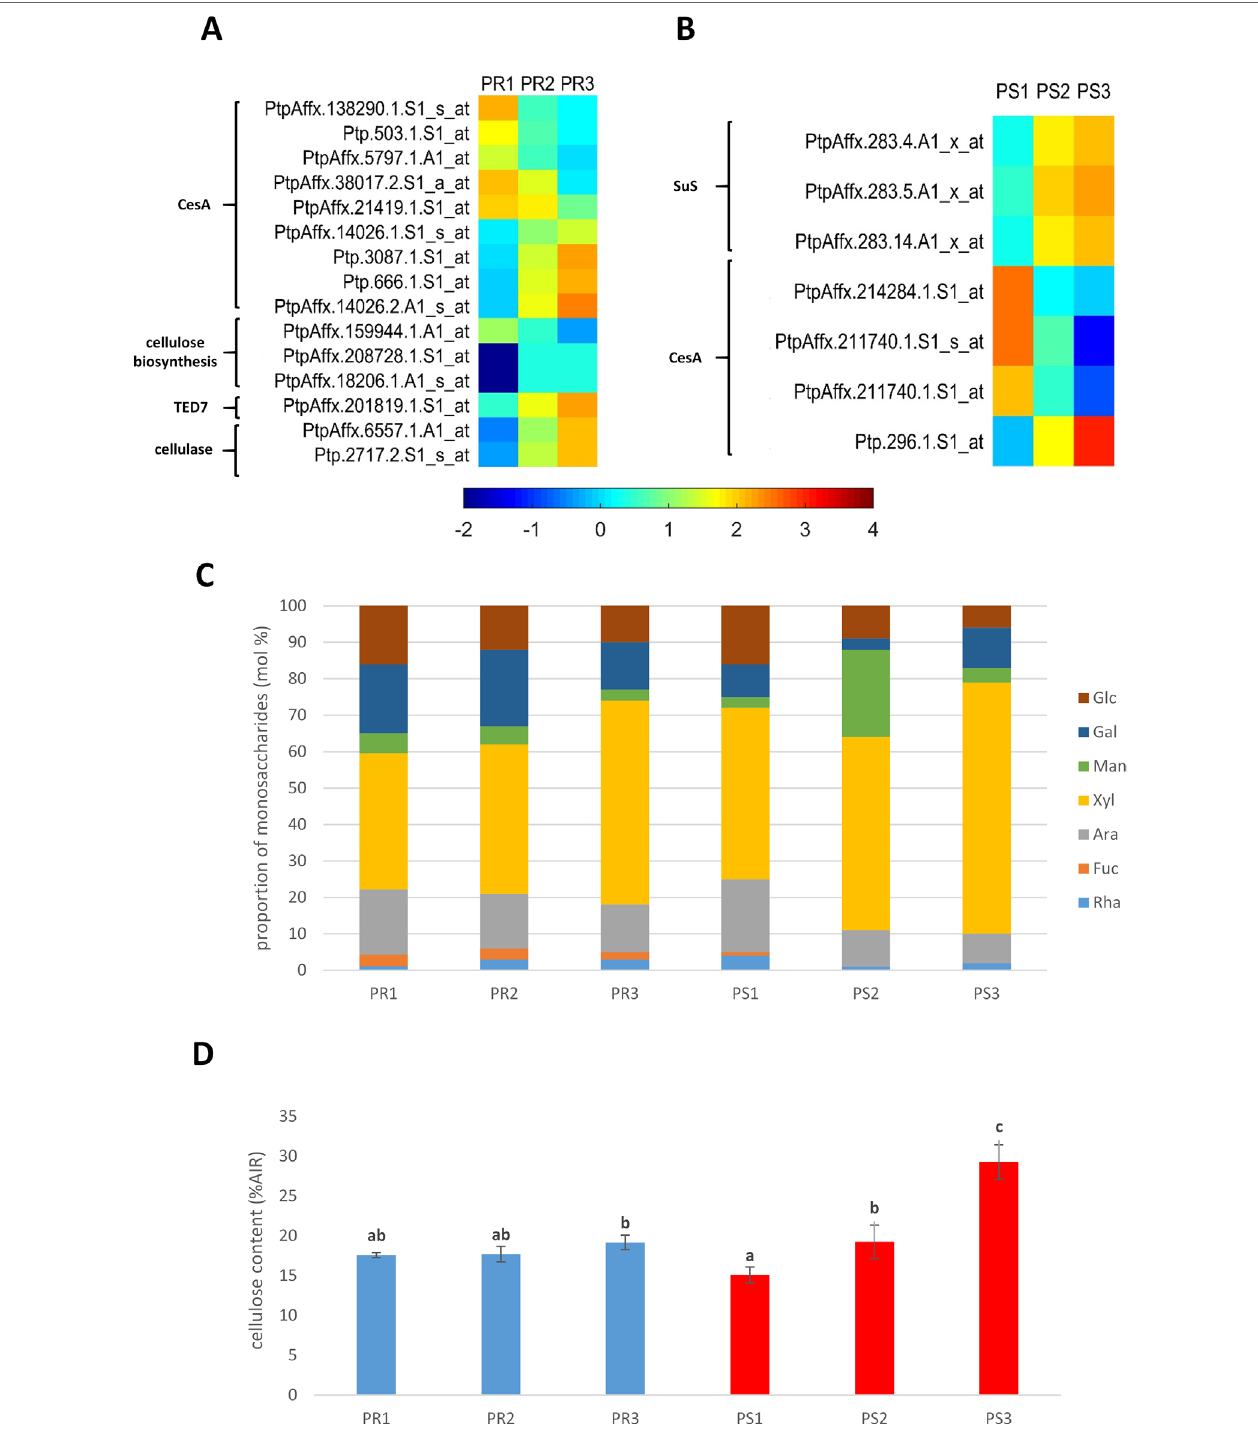
FIGURe 3 | (a) Expression profile of genes related to cellulose metabolism in pioneer roots and (B) stem of black cottonwood. CesA, cellulose synthase; TED7, tracheary element differentiation-related 7 membrane protein; SuS, sucrose synthase. (C) Cell wall monosaccharide composition in pioneer roots and stem of Populus trichocarpa . Cell wall monosaccharide composition was measured from alcohol-insoluble residues extracted from root and stem tissues. Rha, rhamnose; Fuc, fucose; Ara, arabinose; Xyl, xylose; Man, mannose; Gal, galactose; Glu, glucose. (D) Cellulose content in cell walls in pioneer roots and stem of P. trichocarpa . Crystalline cellulose content was measured in alcohol-insoluble residue (AIR) of cell walls with Updegraff method. Means designated by different letters indicate changes statistically significant according to Tukey´s post hoc test, (P < 0.05). Error bars indicate ± SE (n = 4).